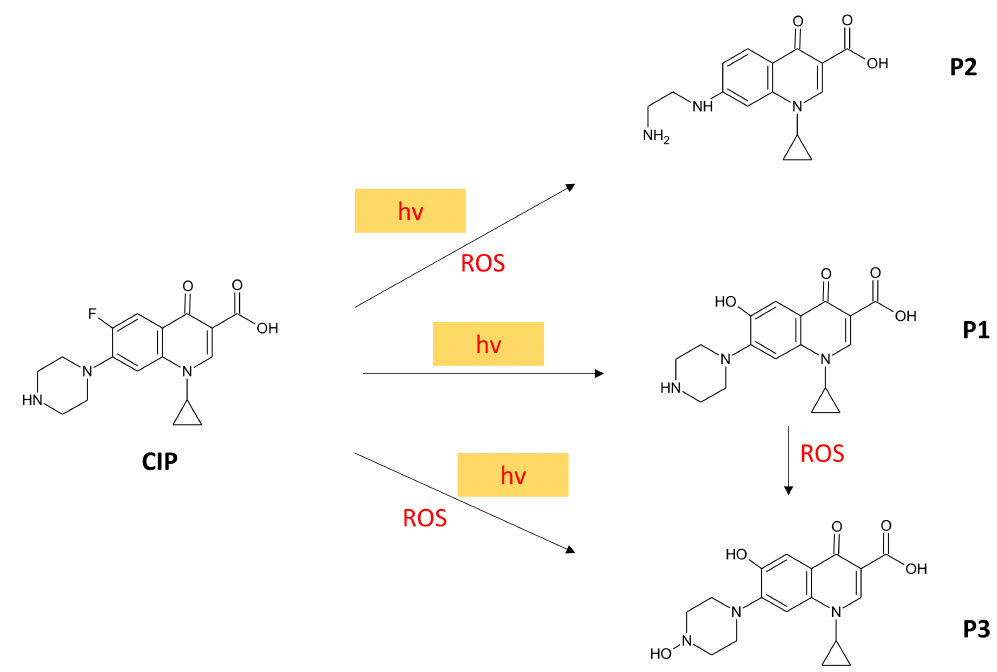
Figure 3. Primary transformations of free and complexed CIP under solar light and UVC light. Main fragments from the MS analyses for these products are summarized in Table